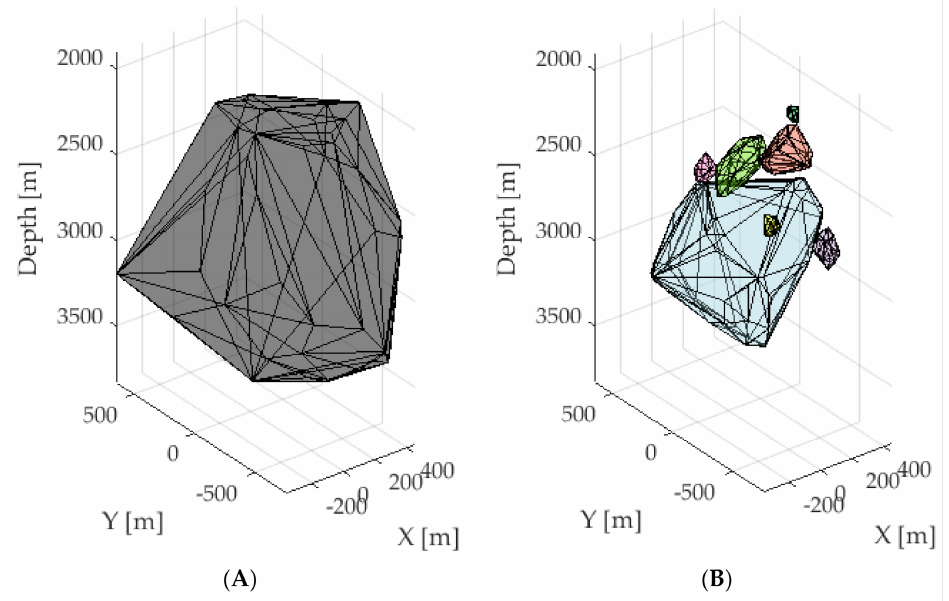
Figure 11. Convex hulls for the clouds of microseismic events ( A ) Convex hull for the microseismic cloud after location. ( B ) Convex hulls for each cluster that can be